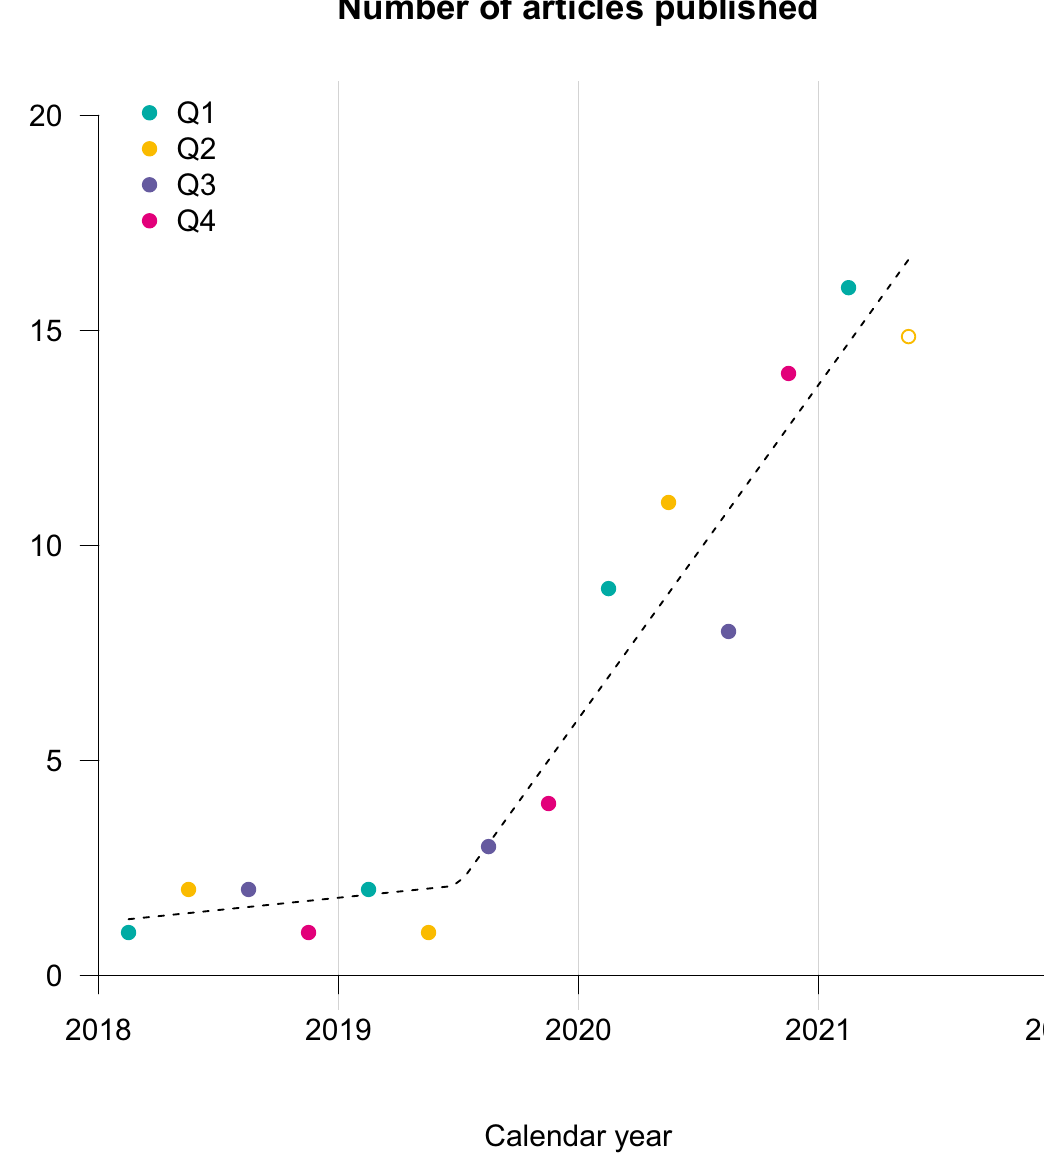
Fig 2. Number of articles published quarterly since 2018. One article [17] published in 2012 is not shown on this graph. 2021/Q2 is an extrapolated value based on the number of articles in the observation period